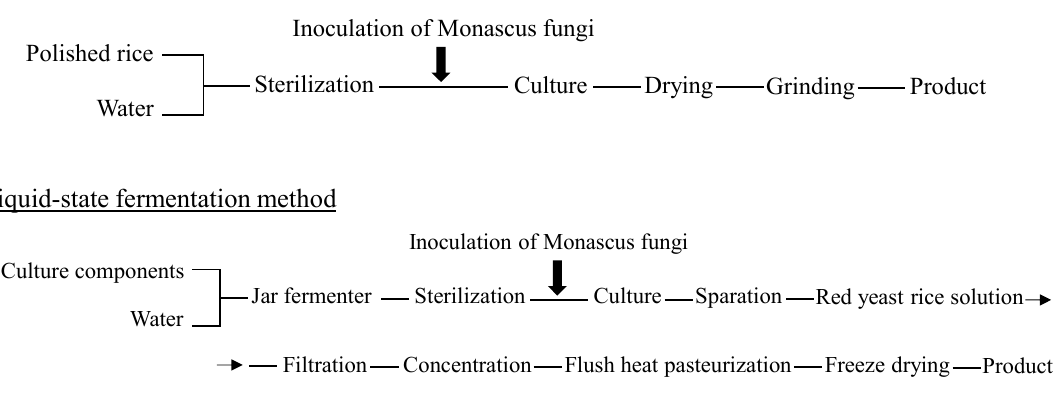
Figure 3. Solid-state/liquid-state culture method of red yeast rice.